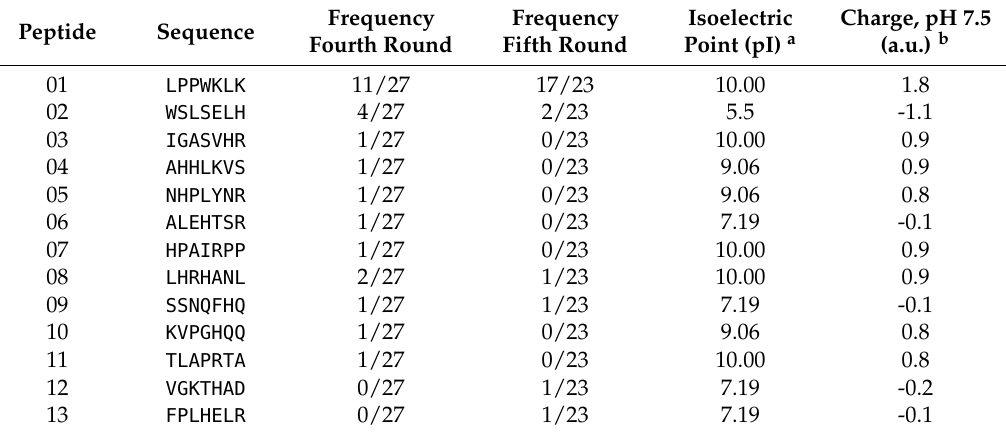
Table 1. Peptides binding to SnO after the fourth and fifth biopanning